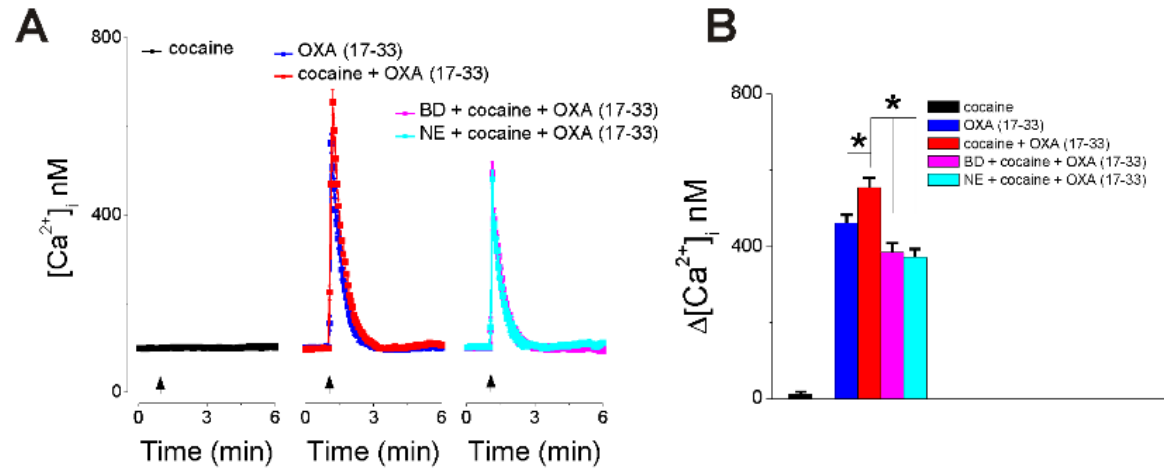
Figure 4. Cocaine potentiates OXA (17-33)-induced increase in [Ca 2+ ] i via Sigma-1R activation. ( A ) Illustration of average Ca 2+ responses ( ± SD) produced by application of cocaine (10 µ M) alone (left, no response), cocaine (10 µ M) and OXA (17-33) (10 nM) (middle), and cocaine and OXA (17-33) in the presence of Sigma-1R antagonists BD1047 (50 µ M) or NE-100 (5 µ M) (right). ( B ) Comparison of the amplitude of the increase in [Ca 2+ ] i (average + SD) in each condition. Cocaine potentiates the Ca 2+ response induced by OXA (17-33), while antagonism of Sigma-1R abolished the potentiation produced by cocaine on the Ca 2+ response elicited by OXA (17-33) (10 nM). * p < 0.05 ( n = 6 neurons/condition). A diagram summarizing the proposed mechanism of potentiation of orexin by cocaine via Sigma-1R activation in nucleus accumbens neurons is illustrated in Figure